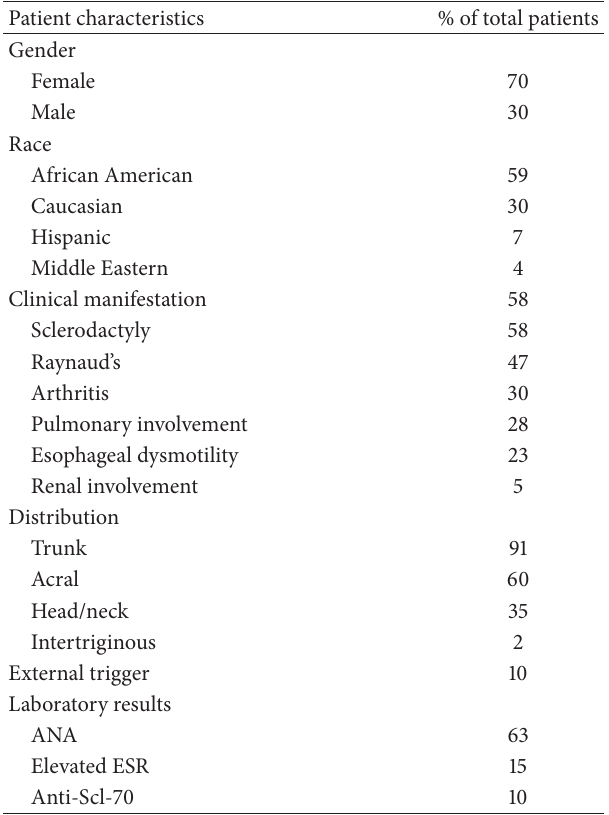
Table 1: Patient characteristics, clinical manifestations, and labora- tory findings in keloidal